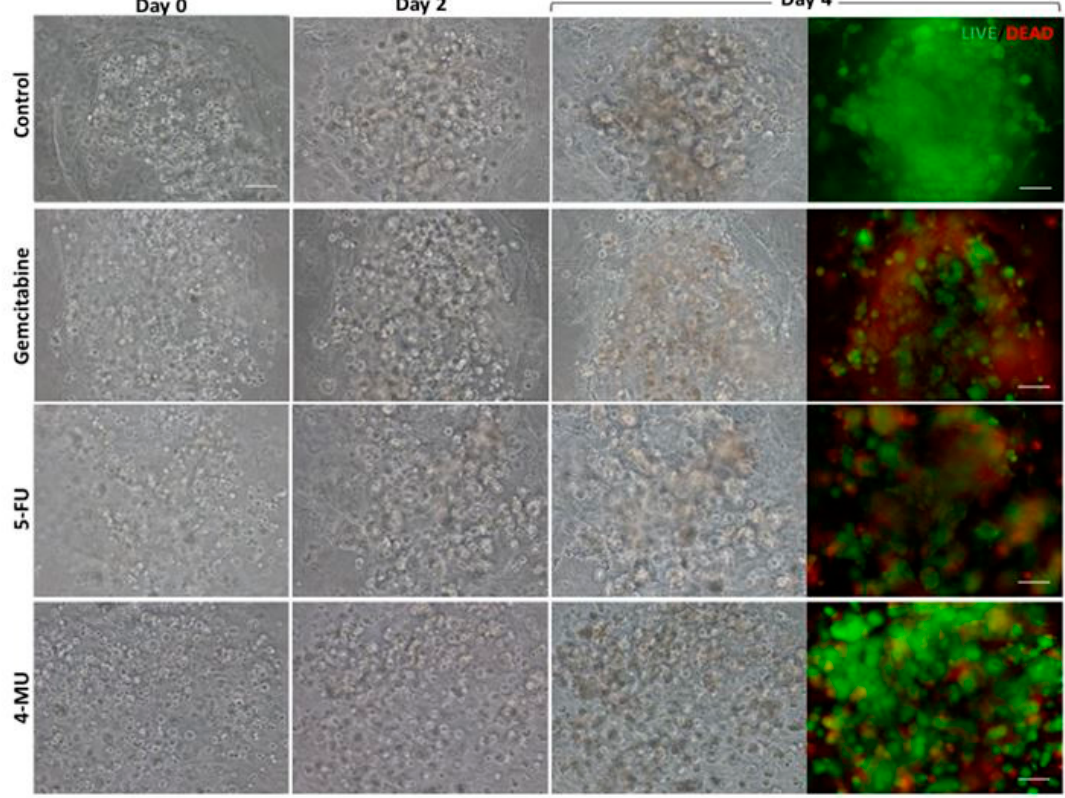
Figure 3. Effect of Gemcitabine, 5-Fluorouracil (5-FU), and 4-Methylumbelliferone (4-MU) on PANC-1 tumor in the 3D co-culture system. PANC-1 cells resuspended in RAD16-I solution were injected into a peptide matrix containing fibroblasts (day 0). Gemcitabine, 5-FU, or 4-MU were added 24 h after the injection. Cells were incubated with the drug for 72 h and assessed for cellular density and viability. Cellular density was evaluated at different time points with phase contrast microscopy, while cellular viability was assessed with Live/Dead at day 4 from the injection. Scale bar: 100 µm. MTS assay was also performed over 3D co-cultures and hNDF monocultures (Figure 4B, right). Significant differences were found between the control group and all the treated groups in both cases, revealing a high cytotoxic effect of these drugs both over co-cultures and hNDF monocultures. In fact, the optical density (OD) obtained for co-cultures belonged mainly to fibroblasts, since no differences were found between co-cultures and hNDF monocultures OD values. Therefore, the OD